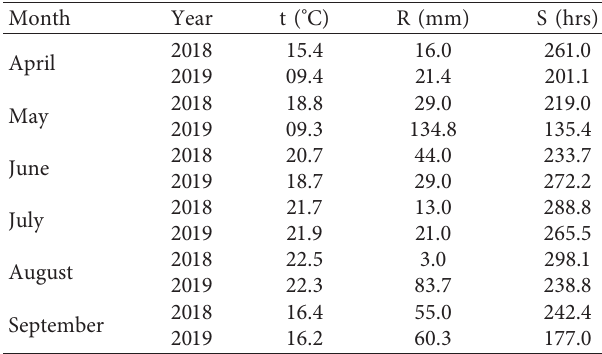
Table 1: Meteodata during the growing cycle in the locality of